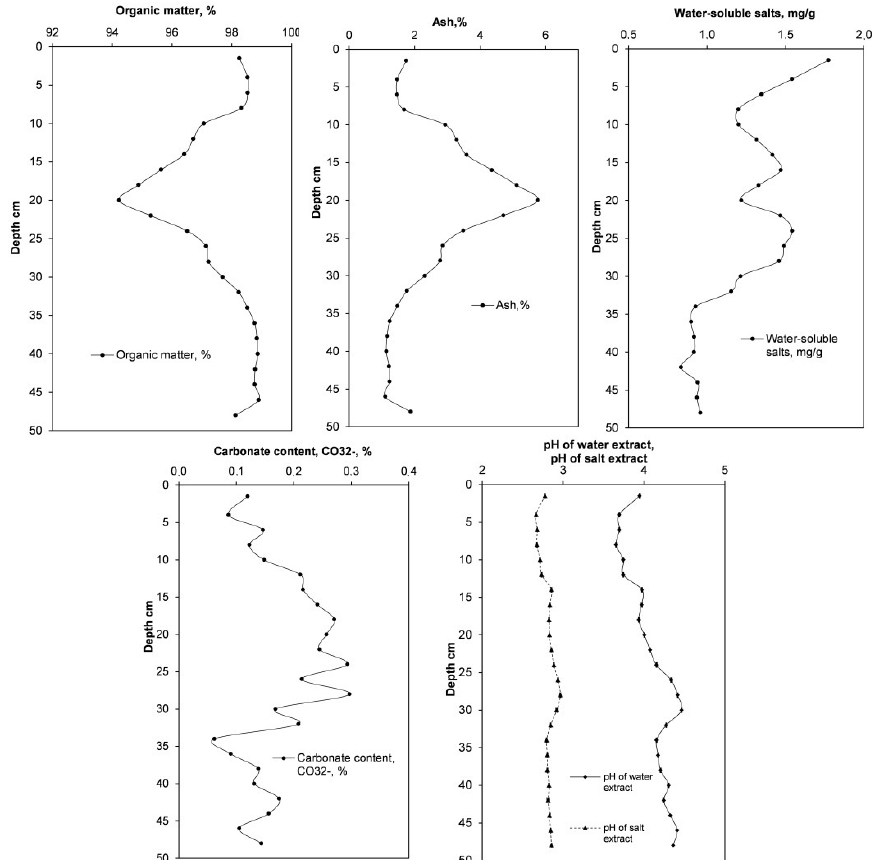
Figure 3. Change in the physicochemical parameters of the peat profile by depth.